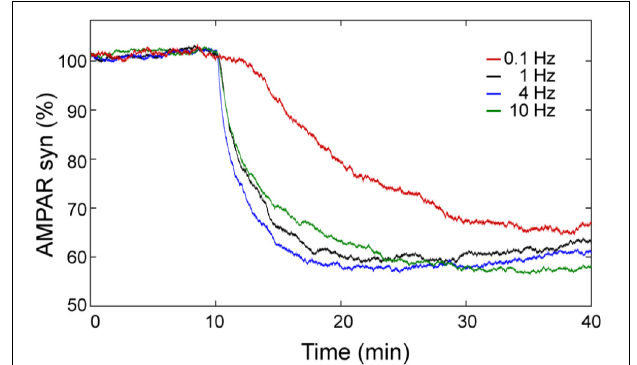
FIGURE 8 | LTD is sensitive to the frequency of Ca 2 + input signal. Mean over time of 100 trials of synaptic AMPAR with varying frequency of calcium pulses showing differences in the LTD amount. LTD was induced at 0.1 (red), 1 (black), 4 (blue), and 10 (green) Hz with the same Ca 2 + input of one hundred of repetitive pulses ( ∼ 2 µ M of amplitude) with a duration of every pulse equal to 200 ms.